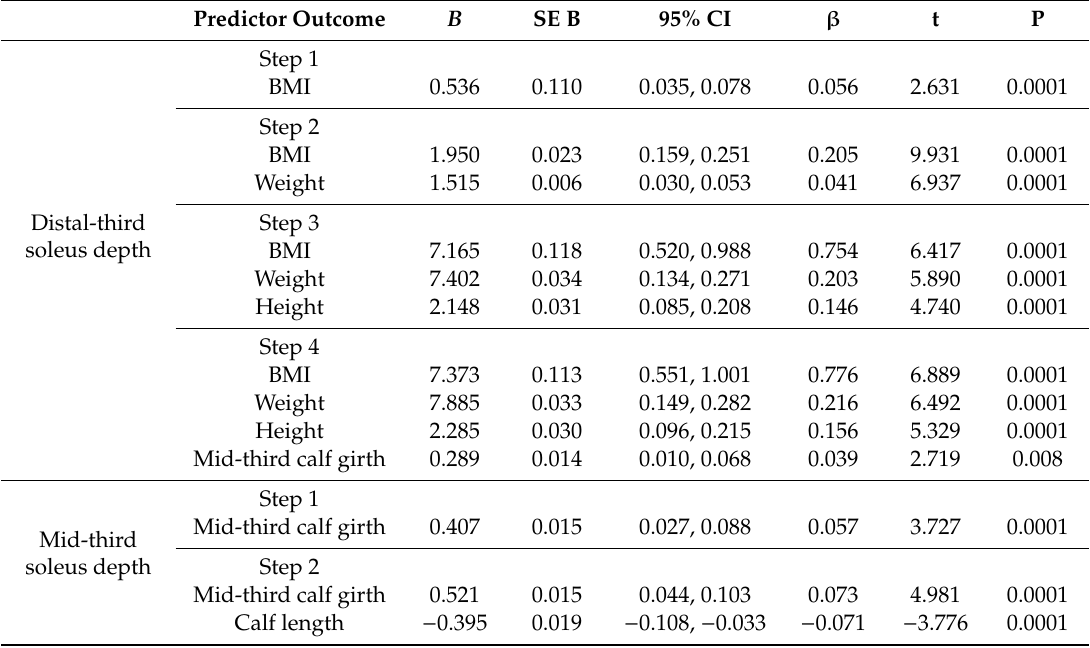
Table 3. Summary of the Regression Analyses to determine Predictors of Soleus Depth in Men.